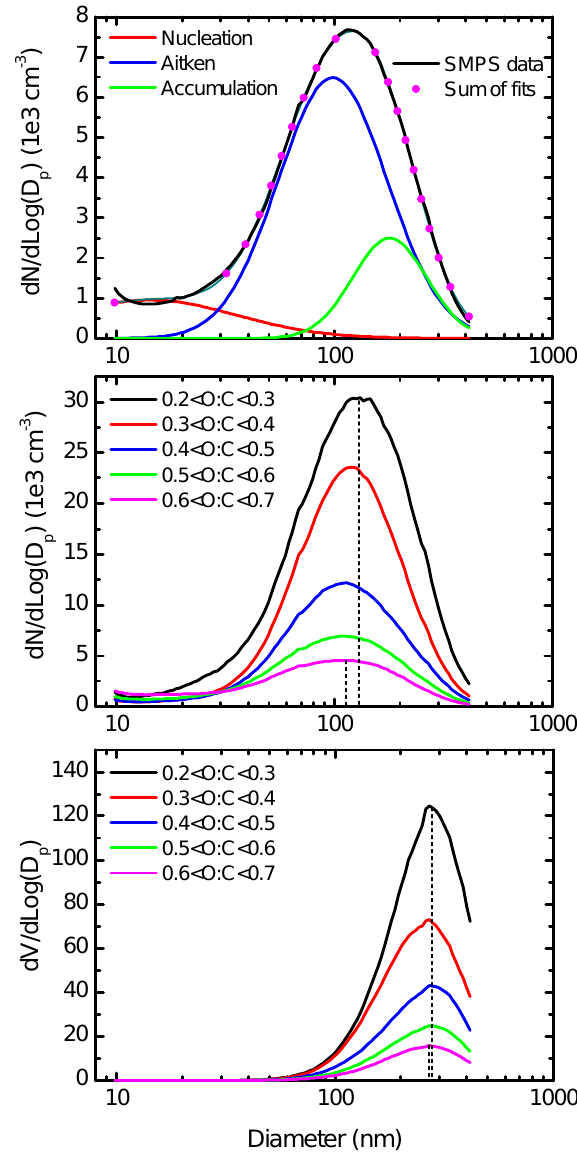
Figure 9. Top: average aerosol size distribution observed at ground level during SAMBBA. The average particle number concentra- tion and diameter were 5800cm − 3 and 94.4nm, respectively. Log- normal fit parameters are shown in Table 2. Middle: solid lines show the average number size distribution based on different O : C ranges. The dashed lines indicate size distribution centroid for fresh (130nm) and aged aerosol (110nm). Bottom: solid lines show the average volume size distribution based on different O : C ranges. The dashed lines indicate size distribution centroid for fresh (278nm) and aged aerosol